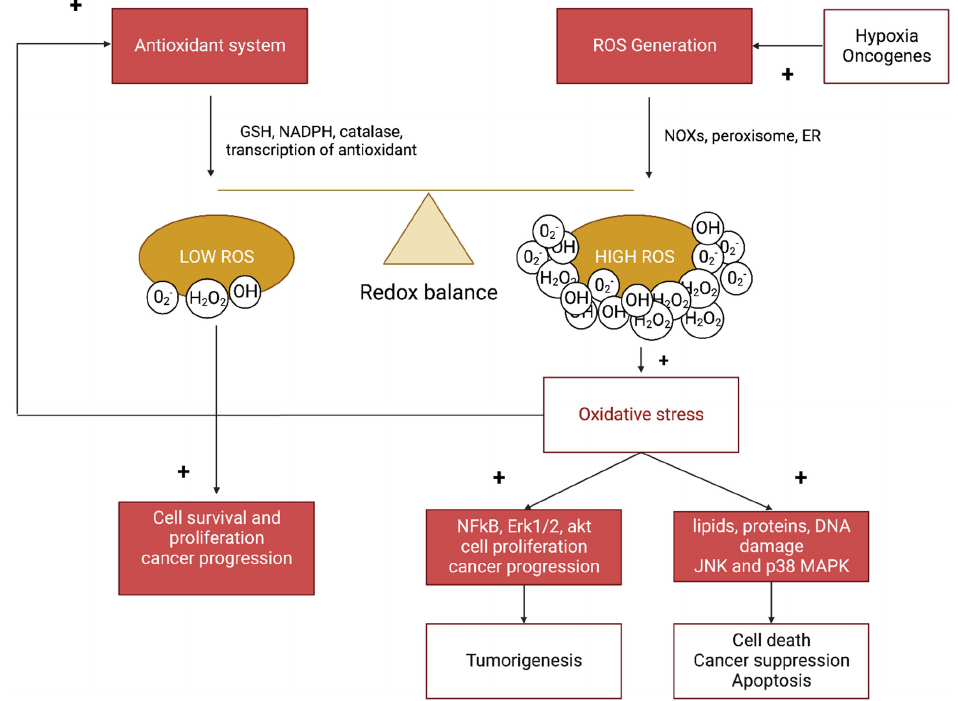
Figure 1. Schematic representation of the redox homeostasis in cancer cells. The redox balance is crucial for normal and cancer cells survival. In normal condition, an increase of ROS generation leads to the activation of different pathways involved in programmed cell death. In cancer cells, metabolism is disrupted and lead to an increase of ROS levels which can also activate different pro oncogenic pathways inducing cell survival and proliferation. To thwart the high rates of ROS, the oxidative stress can also stimulates the antioxidant system to reduce ROS levels and prevent the cells from cell death.